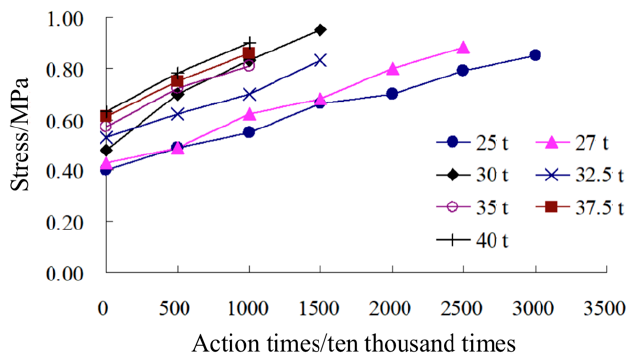
Figure 25. The variation of the maximum longitudinal tension of the base changing with loading times.